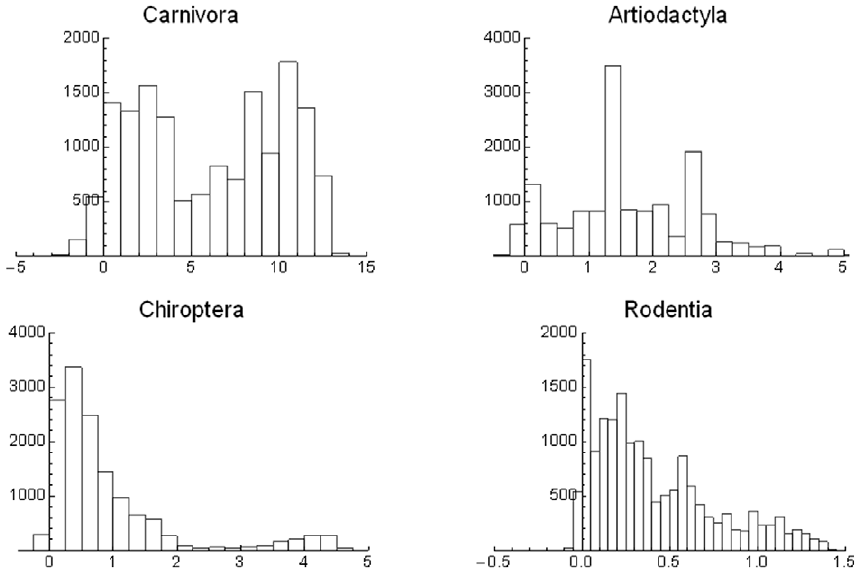
Figure 8. Histograms of mean covariance 6 10 4 of cells in the world, for different Orders of mammals.